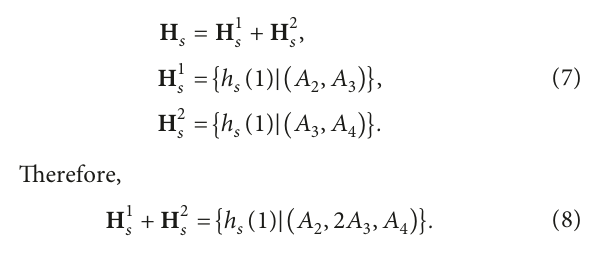
Figure 3: Schematic diagram of the cognitive common range and cognitive system